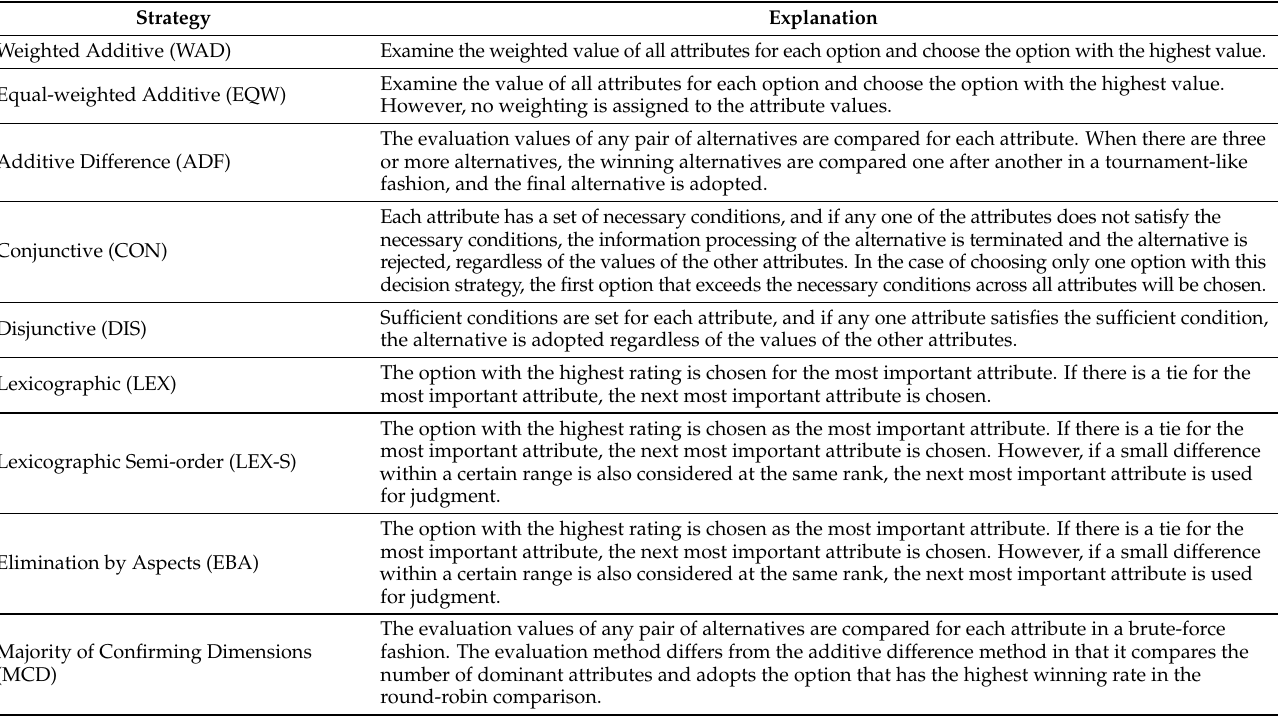
Table A1. Decision strategies used in this study.